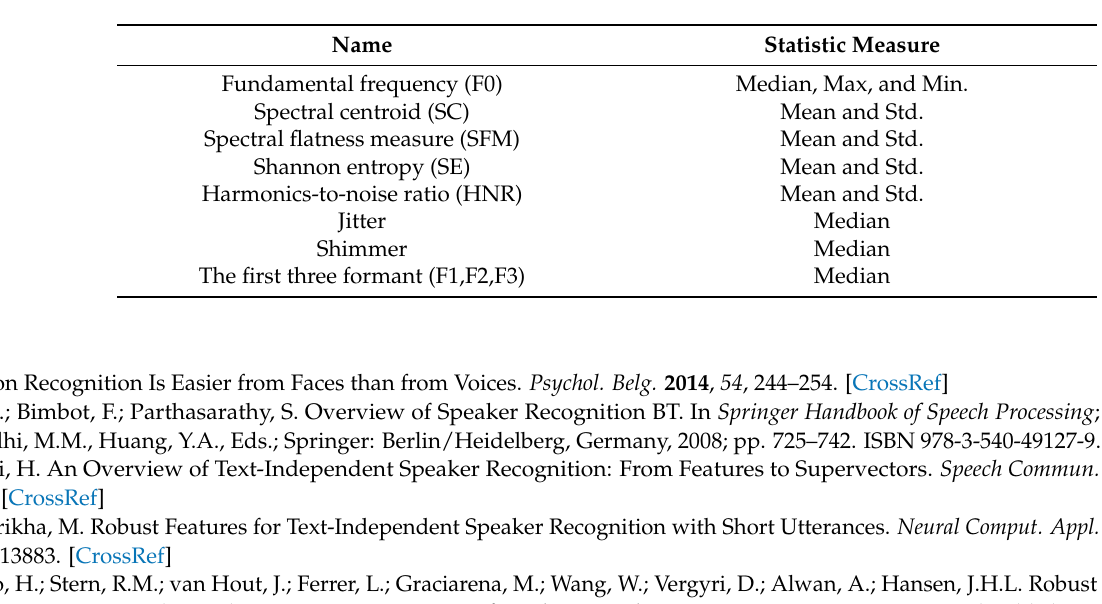
Table A1. Prosodic feature